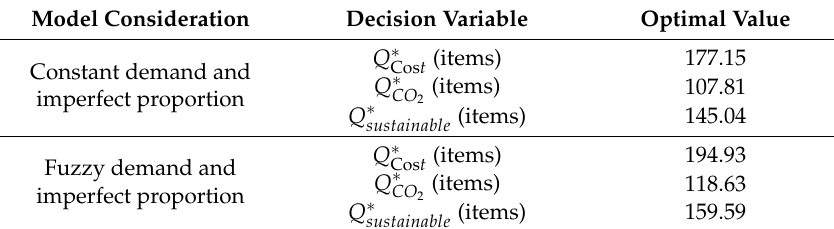
Table 5. Optimal decision variable values.